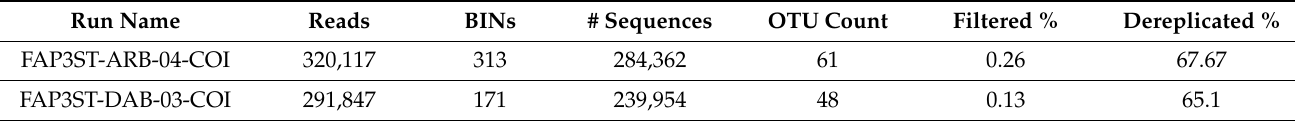
Table 2. The number of reads after processing raw sequences, BINs, and number sequences associated with BIN identifica- tion, remaining OTU counts, percentage of filtered reads (Filtered %), and percentage of dereplicated reads (Dereplicated %) per